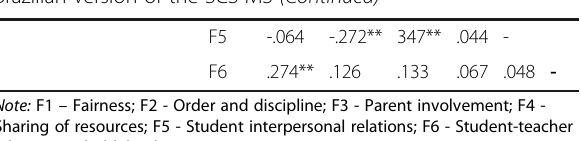
Table 1 Exploratory Structural Equation Modeling (ESEM) of the